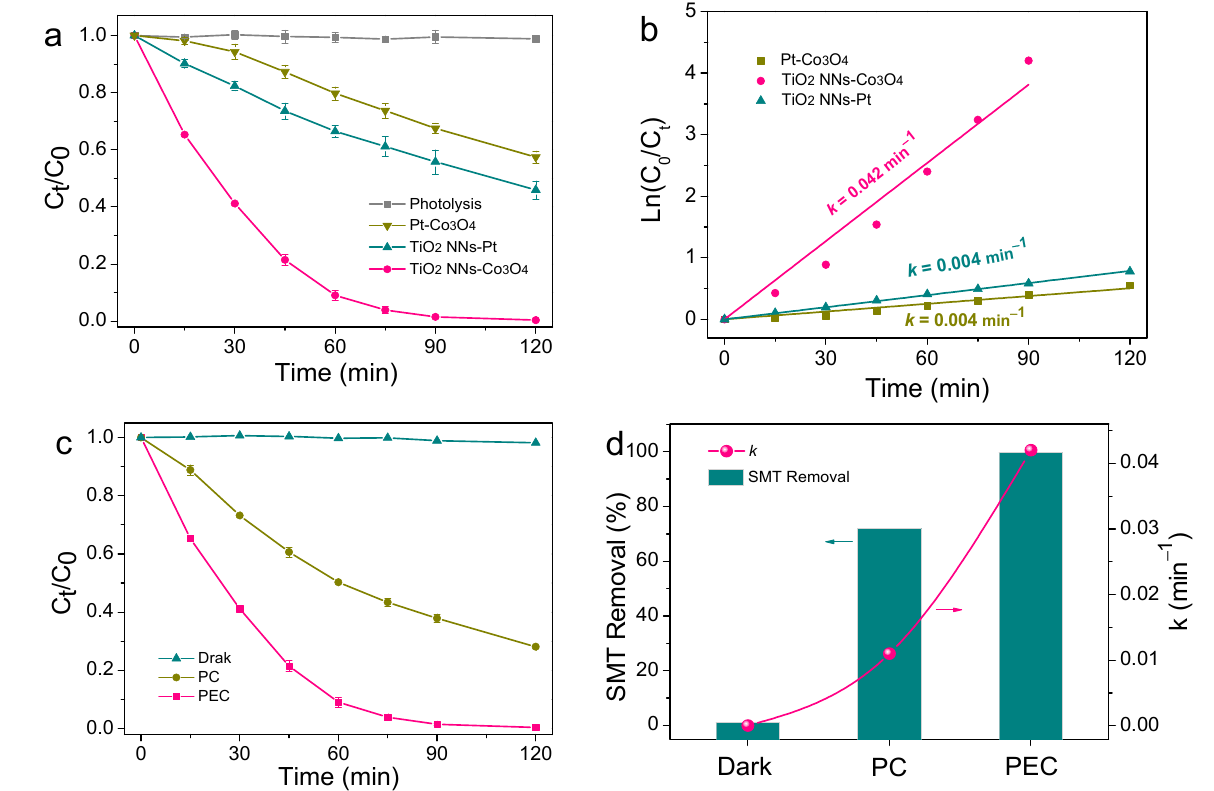
Figure 5. ( a ) Degradation of SMT by direct photolysis, in Pt-Co 3 O 4 , TiO 2 NNs-Pt, and TiO 2 NNs- Co 3 O 4 ; ( b ) the kinetics curves of the above systems. ( c , d ) Removal of SMT by dark, photocatalysis, and photoelectrochemical process using TiO 2 NNs-Co 3 O 4 PEC system.